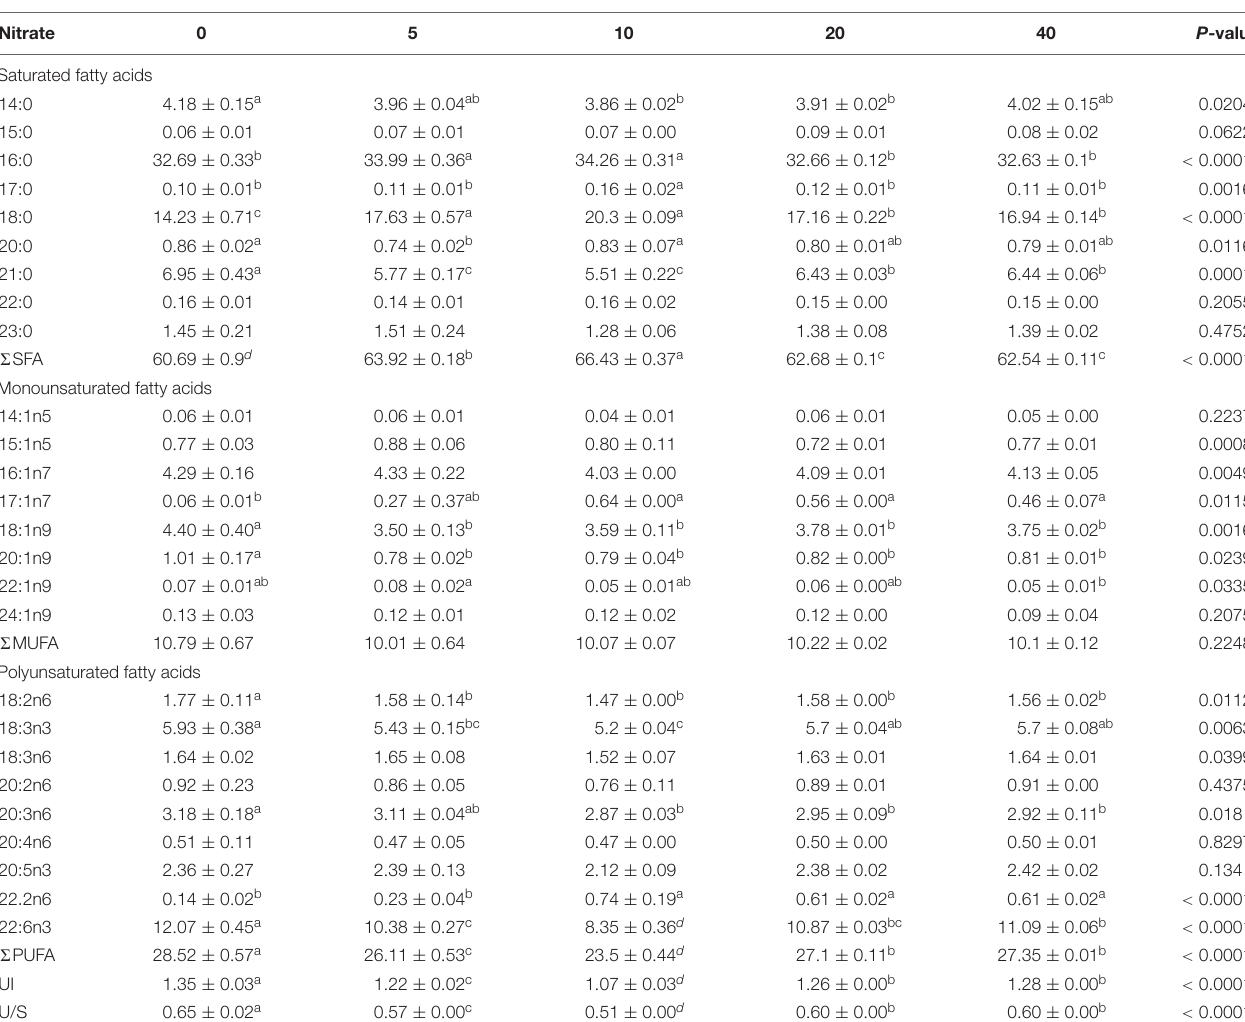
Values are mean ± SD, significant differences (P < 0.05) each row are indicated by different lower-case letters. MUFA, monounsaturated fatty acid; PUFA, polyunsaturated fatty acid; SFA, saturated fatty acid; UI, unsaturated index; U/S, the ratio of unsaturated and saturated fatty acid.